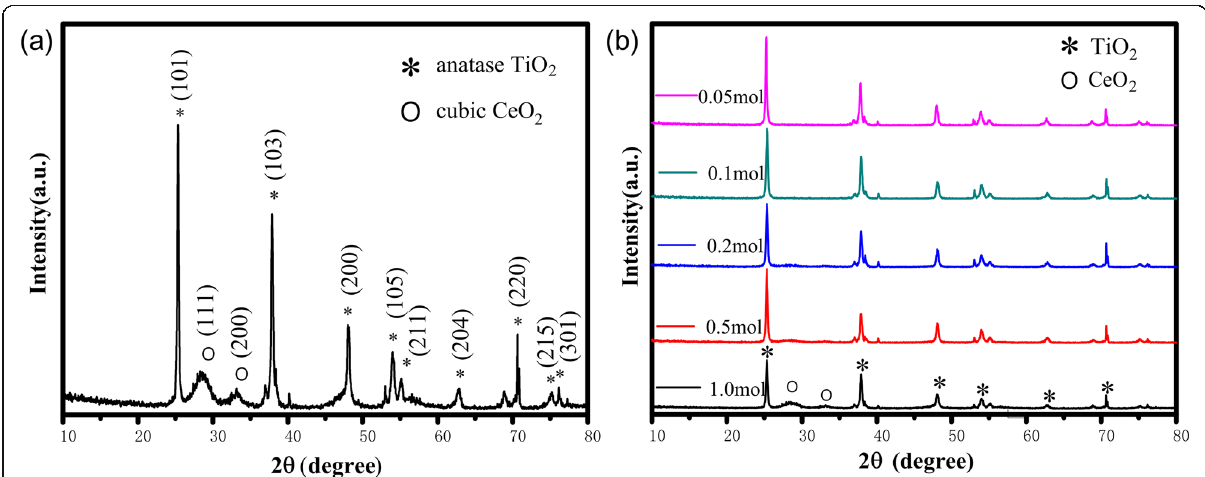
Fig. 3 a XRD pattern of the anatase phase of TiO 2 and cubic CeO 2 . b XRD pattern of the anatase phase of TiO 2 and cubic CeO 2 with different concentrations of Ce(NO